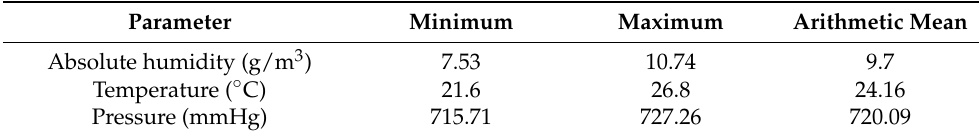
Figure 15. Variation of 50% breakdown voltage with rod (R = 6 mm)–plane electrode system according to different +DC and –DC values: ( a ) +LI; ( b ) –LI. Table 2. Measured ambient conditions for breakdown experiments with rod (R = 6 mm)–plane electrode